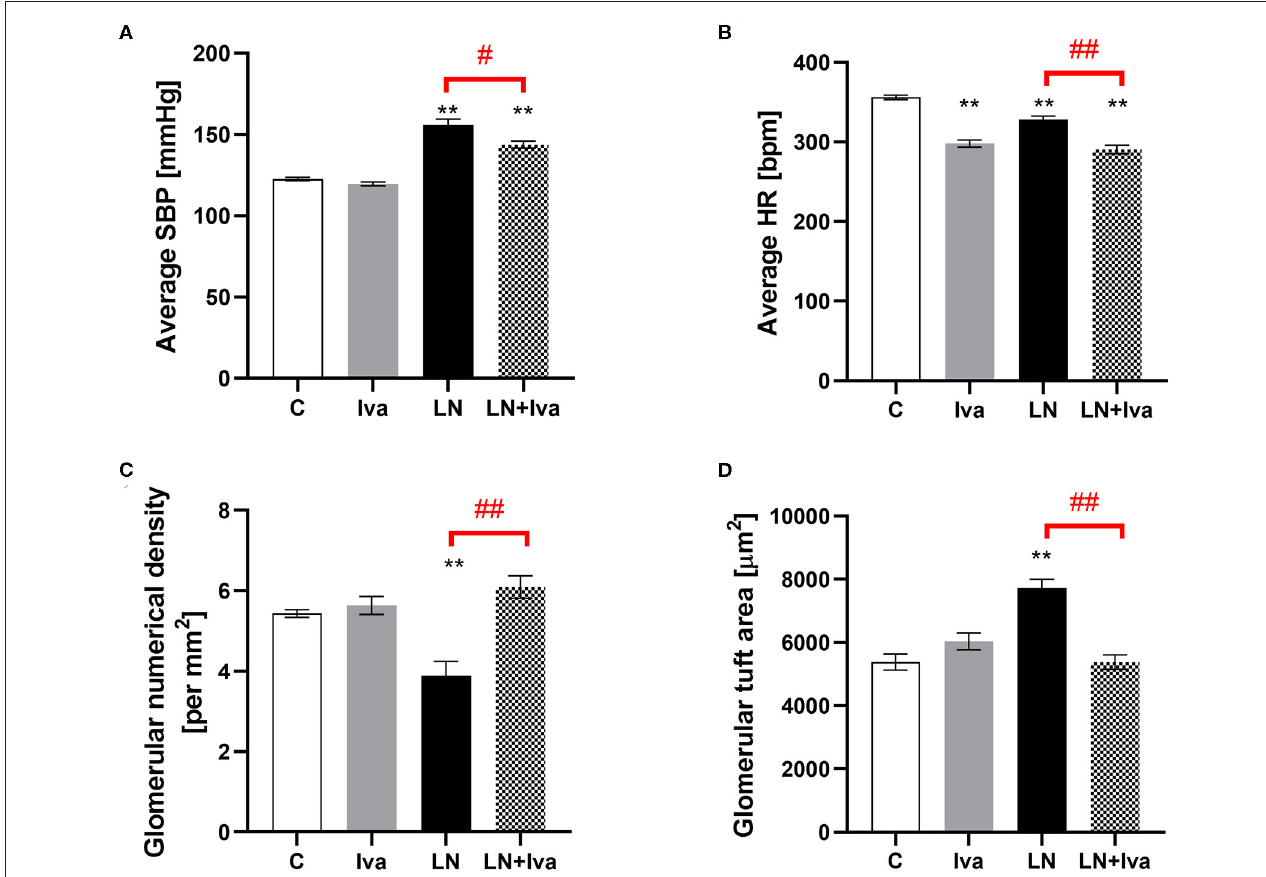
FIGURE 1 | Effect of ivabradine on average systolic blood pressure (SBP) (A) , average heart rate (HR) (B) , glomerular numerical density per area (C) , and glomerular tuft area (D) in L-NAME-induced hypertension after 4 weeks of treatment. C, controls; Iva, ivabradine; LN, L-NAME; n = 9 animals per group. One-way two-tailed ANOVA followed by Holm–Sidak post-hoc test ; ** P < 0.01 vs. C; # P < 0.05 vs. LN; ## P < 0.01 vs.